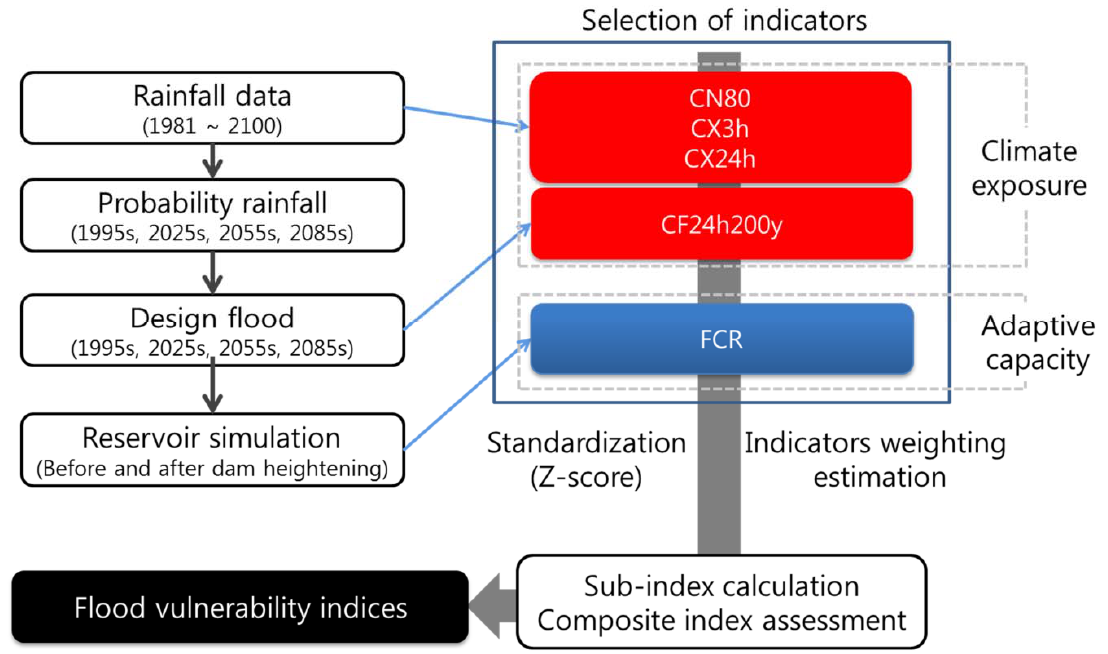
Figure 1. Procedure of flood vulnerability assessment in this study. Refer to Table 1 for CN80, CX3h, CX24h, and CF24h200y.